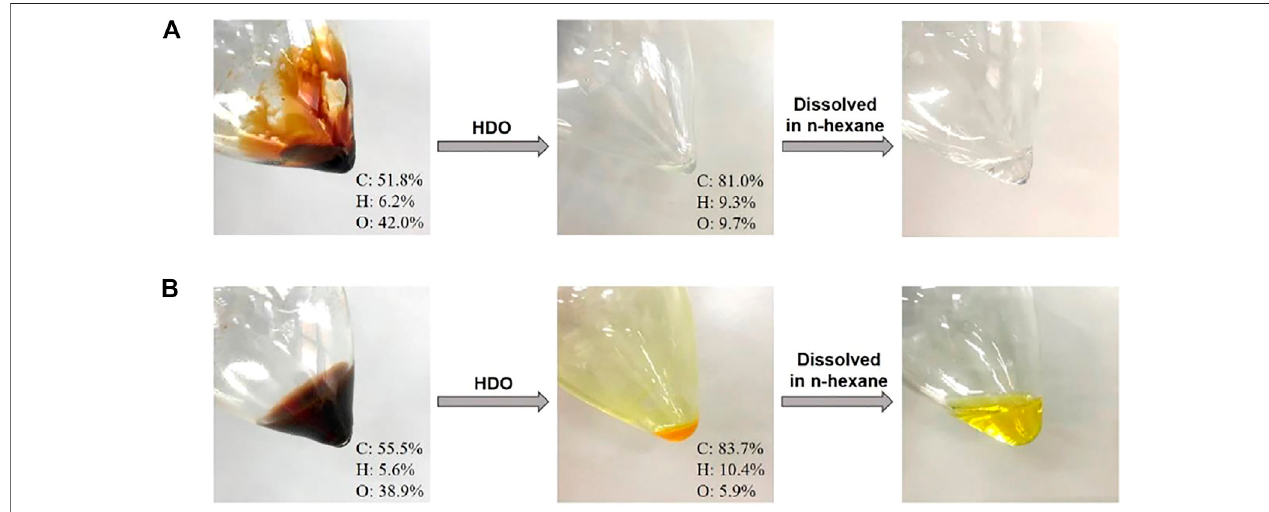
FIGURE 3 | Images of condensed furanic products before and after HDO reactions. (A) The condensed mixture resulting from FA reacting with paraformaldehyde in CH 3 COOH; (B) The condensed mixture resulting from EMF reacting with formaldehyde in